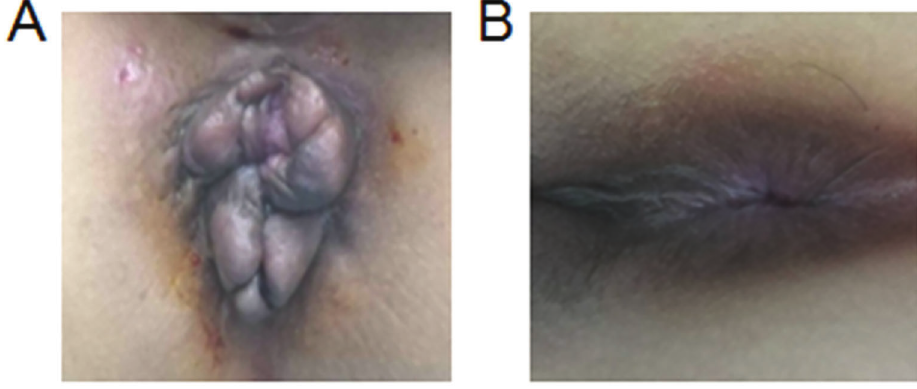
Figure 1. Therapeutic effect of segmental resection combined with anus plasty. A , Representative circumferential mixed hemorrhoids pre-operatively with grade IV internal hemorrhoids and symptoms of prolapse. B , One month post-operatively, the prolapse symptoms were resolved and the hemorrhoids nearly disappeared with grade I anal smoothness.